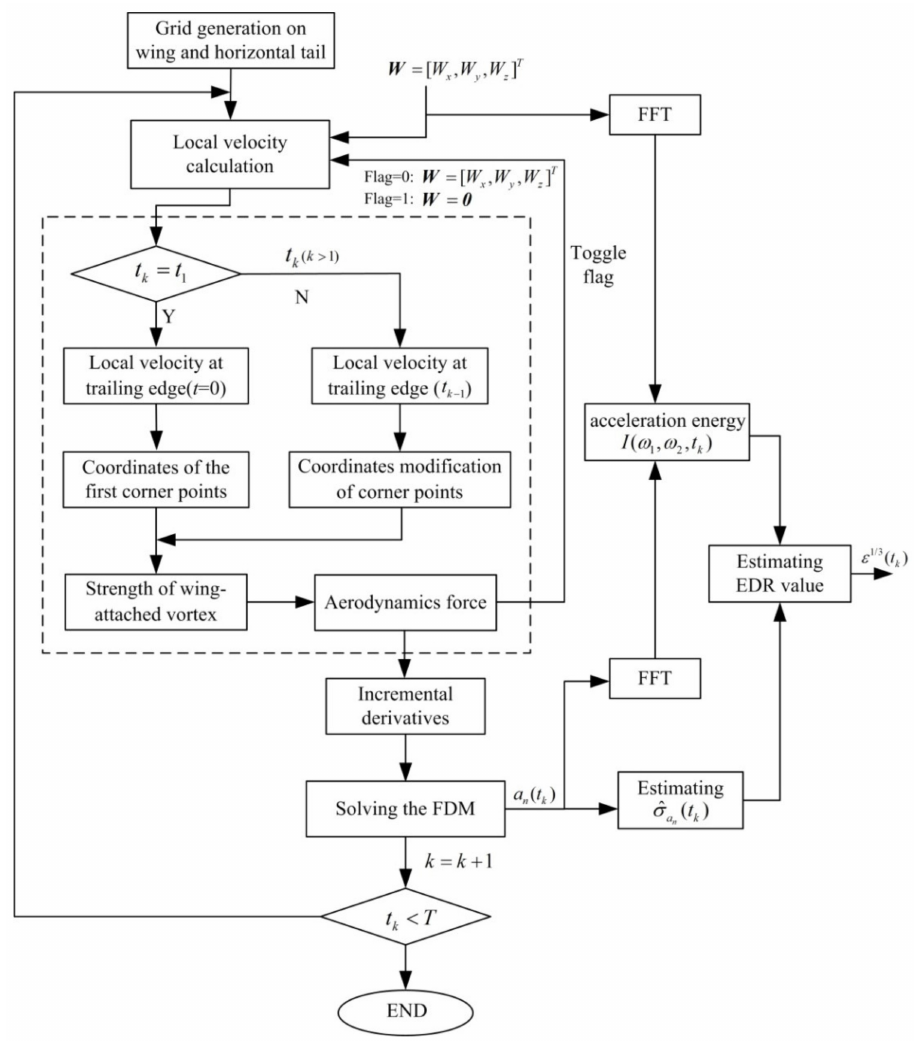
Figure 6. Computation